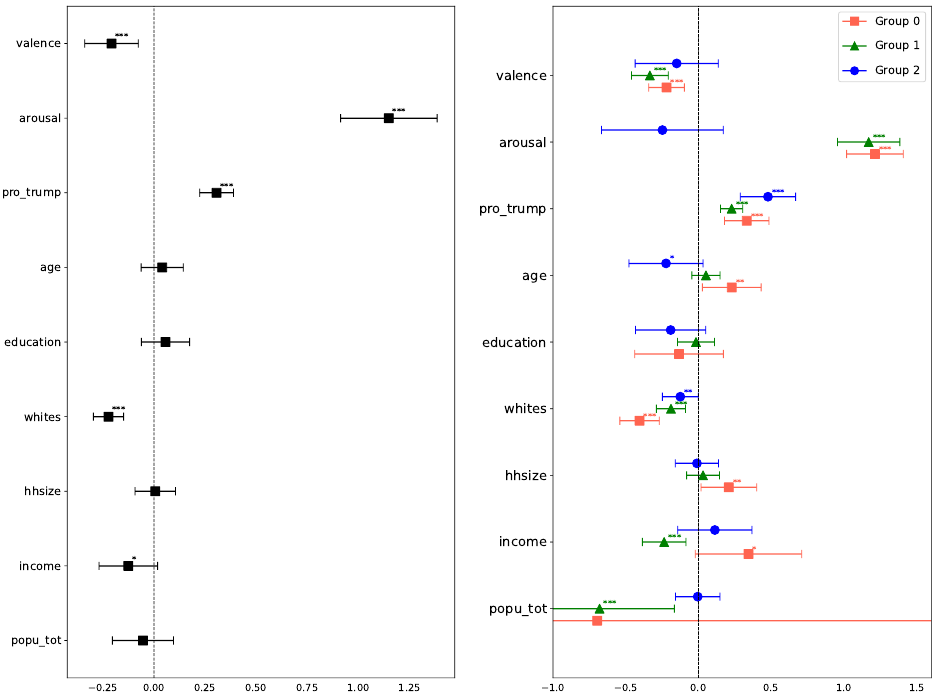
Figure 3. Regression coefficients for the fraction of anti-science users within a county for ( left ) pooled and ( right ) disaggregated data. The groups in the disaggregated data were automatically discovered using the DoGR method. Significance levels of the coefficients are as follows: p < 1% (***), p < 5% (**), p < 10%